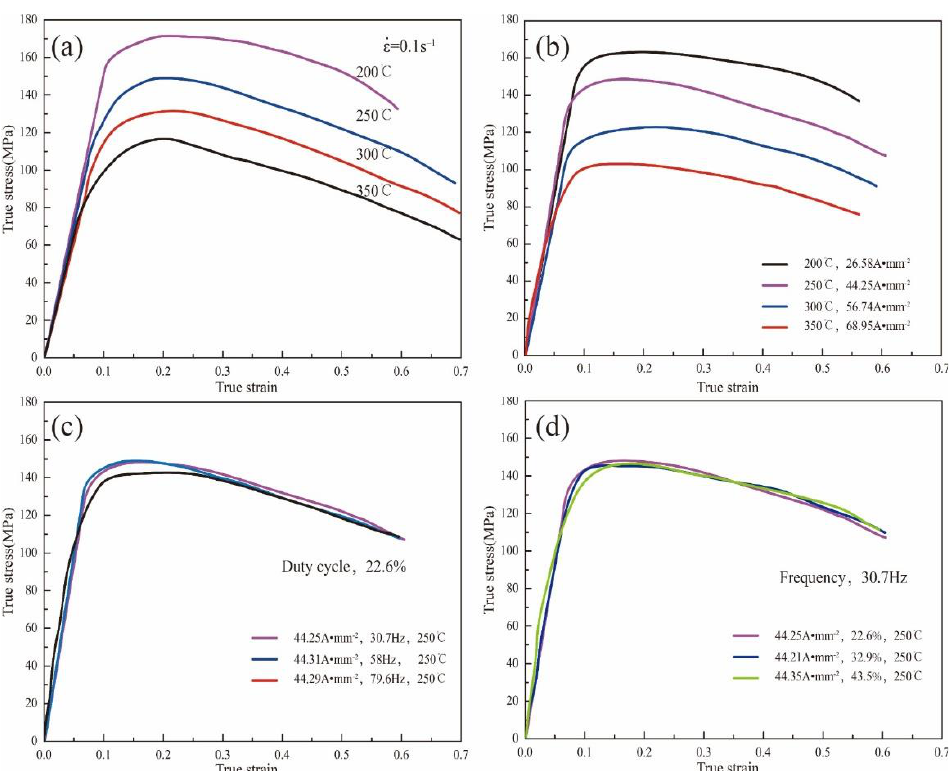
Figure 4. True stress–strain curves of the Mg 98.5 Zn 0.5 Y 1 alloy subjected to electrically-assisted tests. ( a ) 𝜀̇ = 0.1 s − 1 ; ( b ) pulse current density; ( c ) pulse frequency; ( d ) duty ratio .